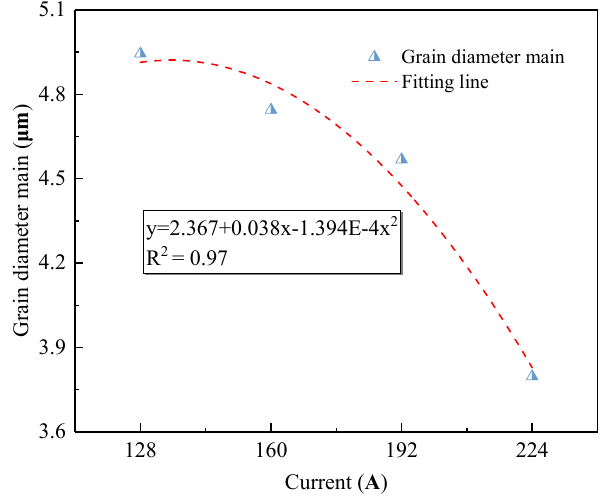
Figure 8. Mean grain diameter of OABs for different overcurrents.